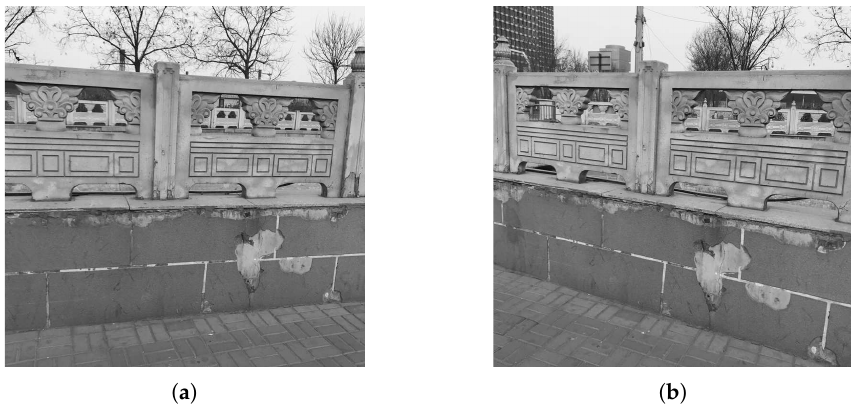
Figure 8. Fence image pair. ( a ) Reference image. ( b ) Sensed image.